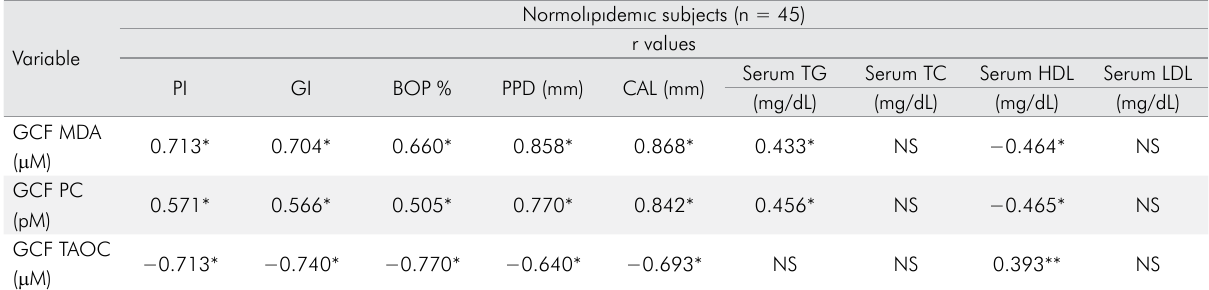
Table 4. Correlations between periodontal clinical measurements and biochemical parameters in normolipidemic subjects.